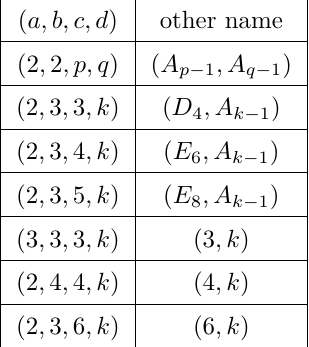
Table 2 . The various infinite sequences of type I singularities. Here the entries of the four- component vector in the left-hand column represent, respectively, the different powers of x , y , u , and v in (2.42). Each set of solutions leads to an isolated singularity at a finite distance in moduli space [27, 28]. The first four entries are of the ( g , g 0 ) type indicated in the second column. The (3 , k ) , (4 , k ) , and (6 , k ) theories are studied in [24, 26, 51, 52] (we use the notation of [52]). There is some overlap between the different theories (e.g., ( D ) ’ (3 , 2) ). There are also a finite set of 4 , A 2 additional sporadic type I singularities and corresponding theories. This table is adapted from